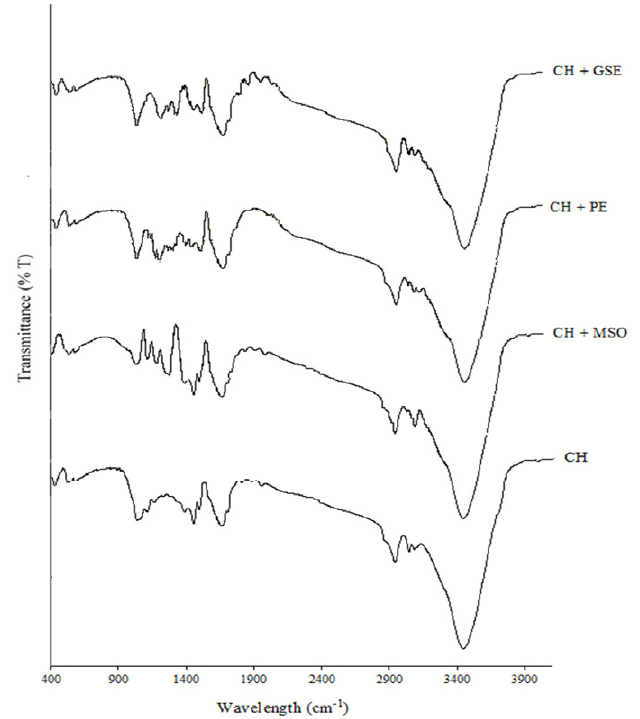
Fig. 2. FTIR spectra of CH (chitosan), CH + M. spicata essential oil (MSO), CH + pomegranate peel extract (PE) and CH + grape seed extract (GSE) films